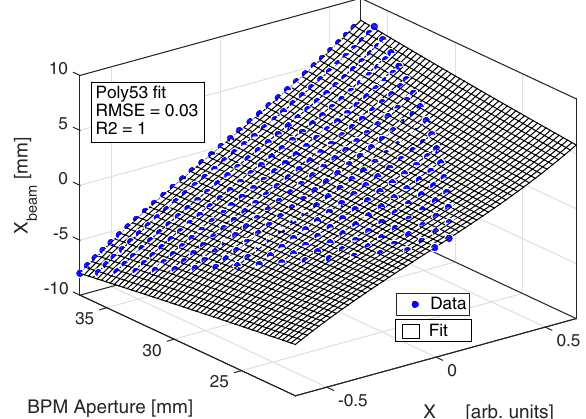
FIG. 12. The Poly53 2D polynomial fit used to correct the nonlinear BPM readings of the TCTPV.4R2.B2 for the opera- tional jaw motion